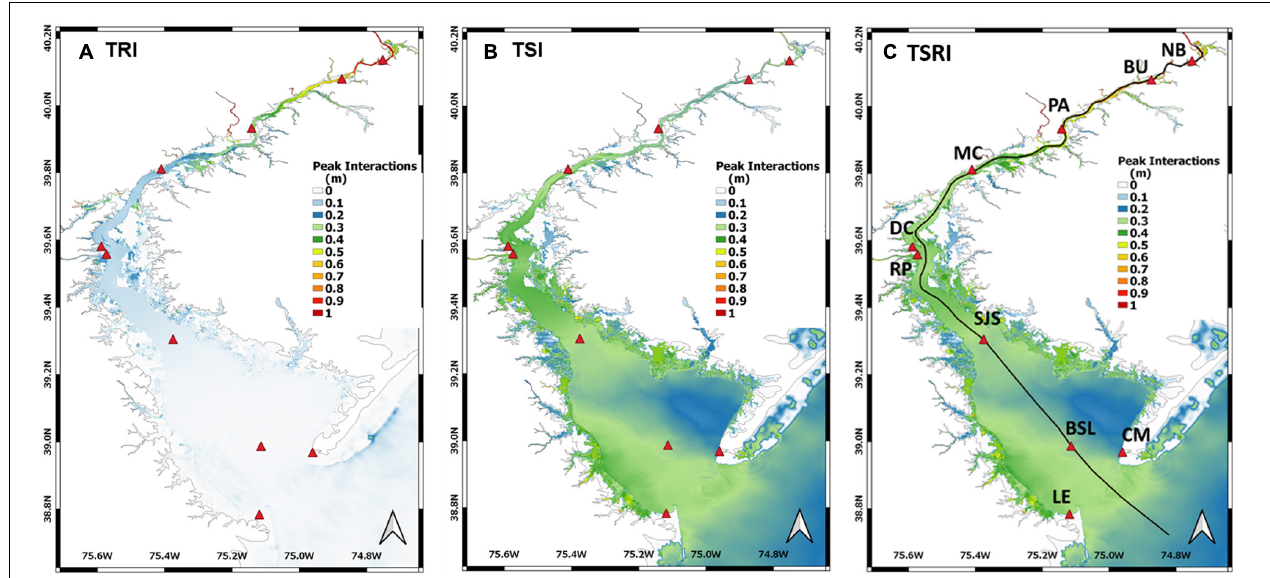
FIGURE 11 | Spatial variations on peak values of (A) TRI, (B) TSI, and (C) TSRI during Hurricane Irene in the DBE. Tide gauges are labeled as red triangles.